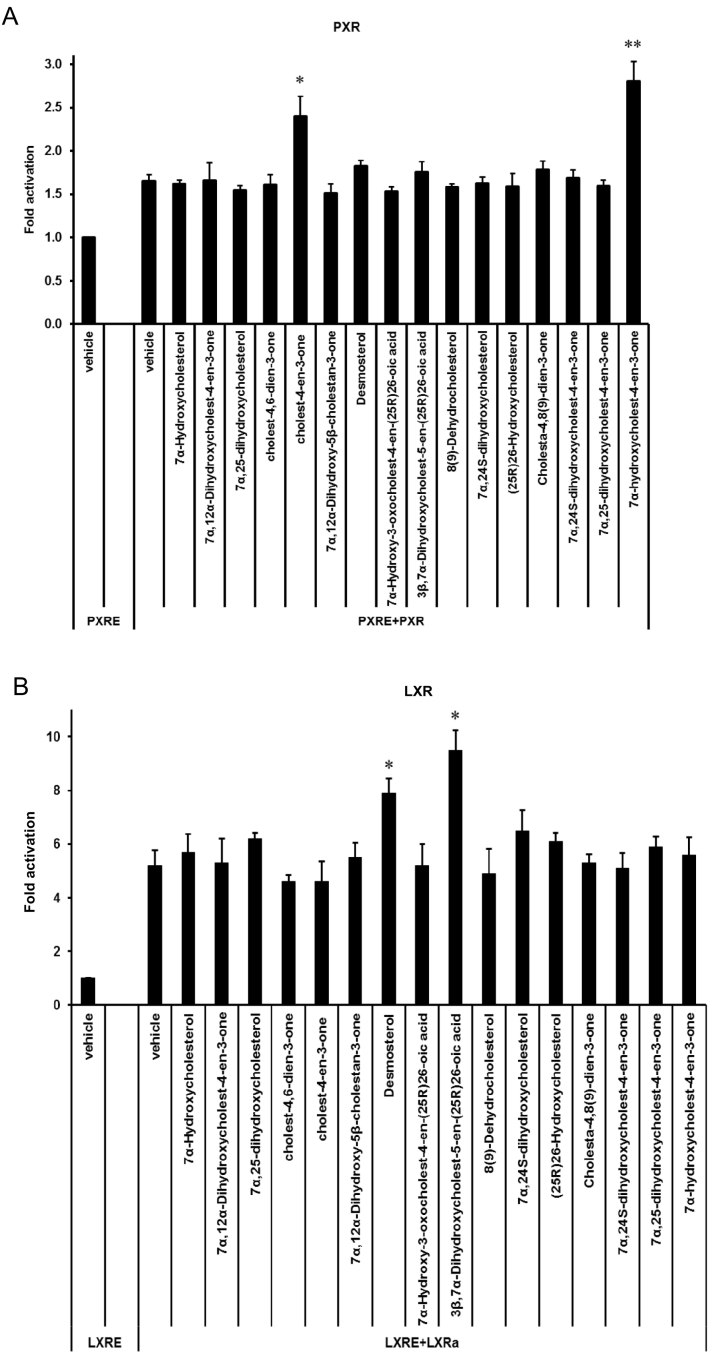
Analysis of the PXR activational capacity of sterols and oxysterols of enhanced or changed abundance in Cyp27a1−/− mouse. Luciferase activity in SN4741 neural cells transfected with (A) a PXR-responsive luciferase reporter construct (PXRE) and PXR, and (B) an LXR-responsive luciferase reporter construct (LXRE) and LXRα, and stimulated for 24 h with the compounds indicated (10 μM). Cholest-4-en-3-one and 7α,24-dihydroxycholest-4-en-3-one were increased in brain but not in plasma, 7α,12α-dihydroxycholestan-3-one was elevated in plasma but not in brain, 7α,(25S)26-dihydroxycholest-4-en-3-one and 7α,12α,25-tihydroxycholest-4-en-3-one are not commercially available, while 7α-hydroxy-3-oxocholest-4-en-(25S)26-oic is only available as an unresolved mixture with the 25R epimer. (25R)26-Hydroxycholesterol and desmosterol were reduced in both brain and plasma of the Cyp27a1−/− mouse, 7α-hydroxy-3-oxocholest-4-en-(25R)26-oic acid was reduced in plasma only.